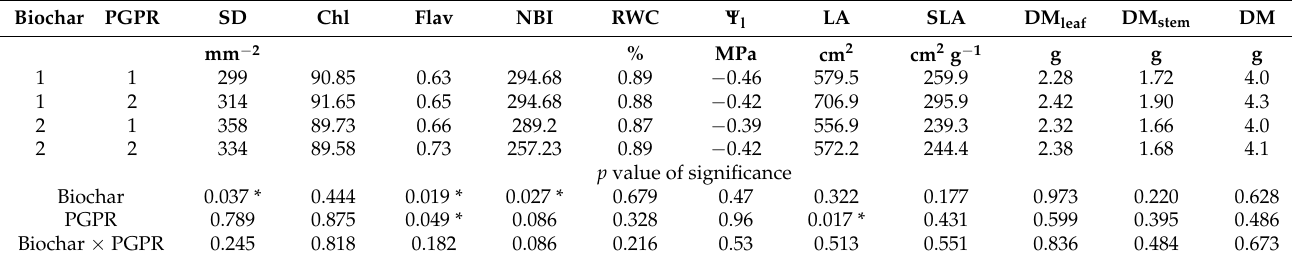
Table 1. Stomata density (SD), chlorophyll (Chl), flavonoids (flav), nitrogen balance index (NBI), relative water content (RWC), leaf water potential ( Ψ l ), leaf area (LA), specific leaf area (SLA), dry mass of leaf (DM leaf ) and stem (DM stem ) and total dry mass (DM) as affected by biochar amendment and PGPR inoculation at first